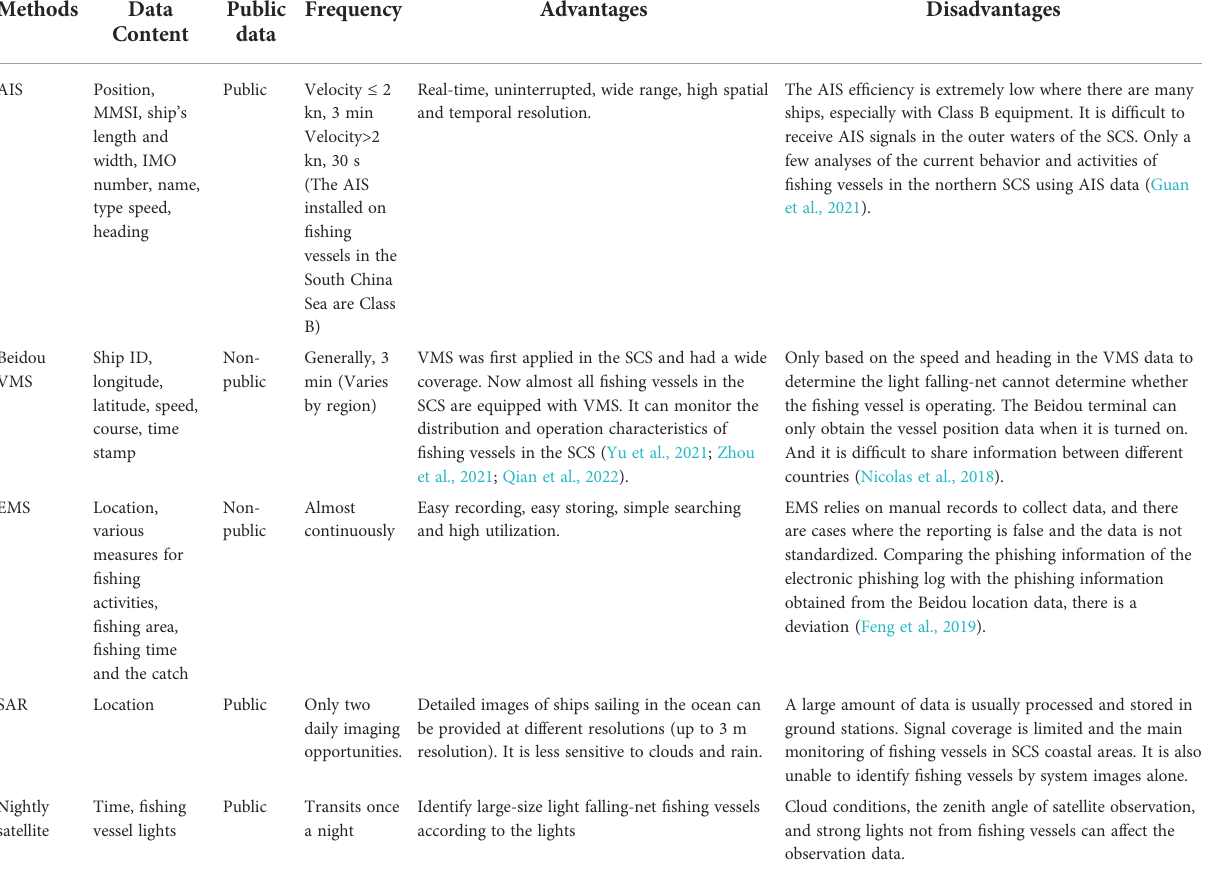
TABLE 3 A comparison of selected methods for vessel monitoring in the South China